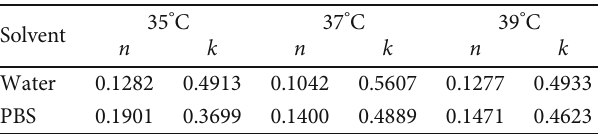
Figure 8: TGA results: (a) TGA curves for HPC/PAAm gel and HPC/PAAm gel with incorporated acetaminophen; (b) DTG curves for HPC/PAAm and HPC/PAAm with incorporated acetaminophen. Table 1: Values of n obtained for the release of acetaminophen in